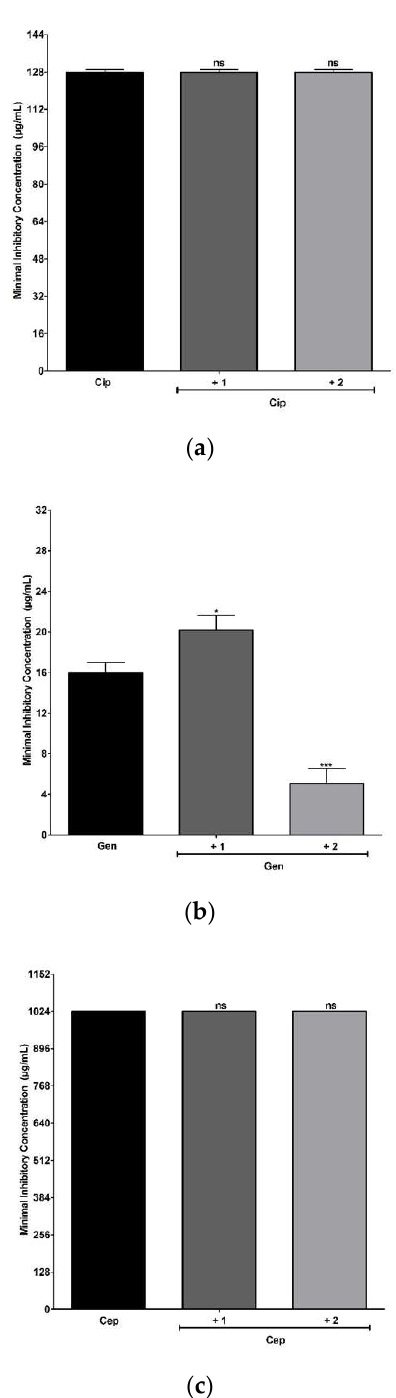
Figure 8. Minimum inhibitory concentration (MICs) of the Ciprofloxacin (Cip) (a), Gentamicin (Gen) (b), and Cephalexin (Cep) (c) in the absence or presence of the chalcones 1 and 2 at sub-inhibitory concentrations (MIC 1/8) against multidrug-resistant S. aureus SA10. Each result is the geometric mean of three simultaneous experiments. (***) Statistically significant values ( p < 0.0001); (*) ( p < 0.05).